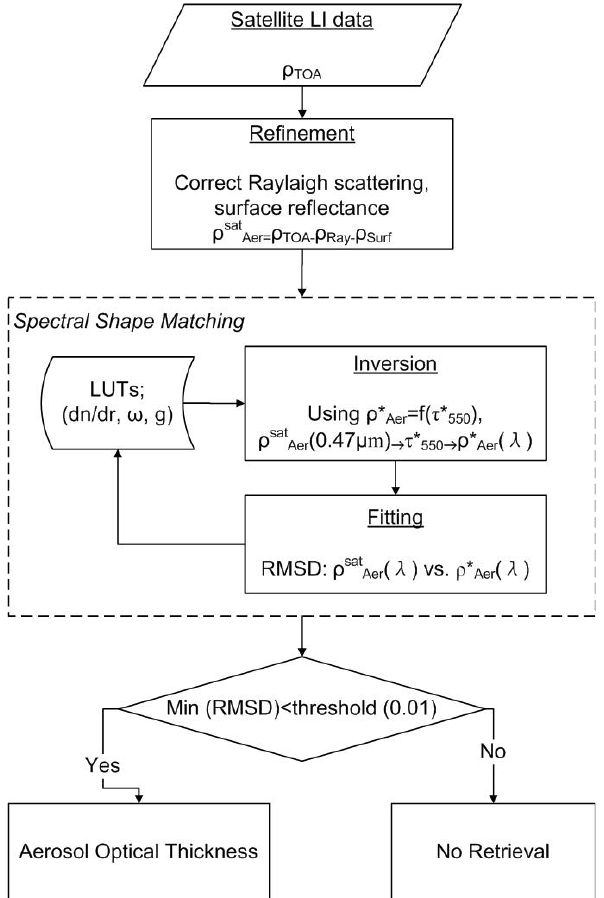
Fig. 8. Schematic diagram of aerosol retrieval.